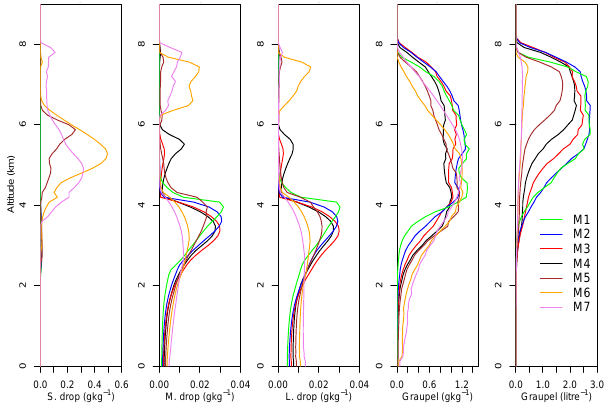
Fig. 15. As Fig. 13, but at 30min.